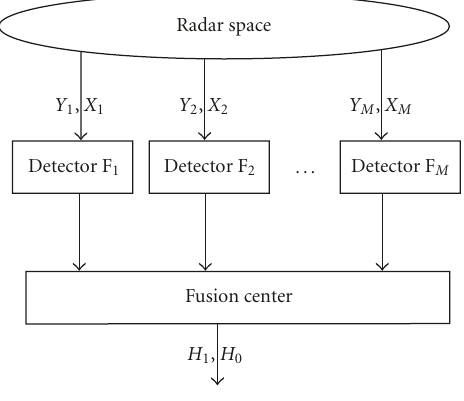
Figure 2: Decentralized detection